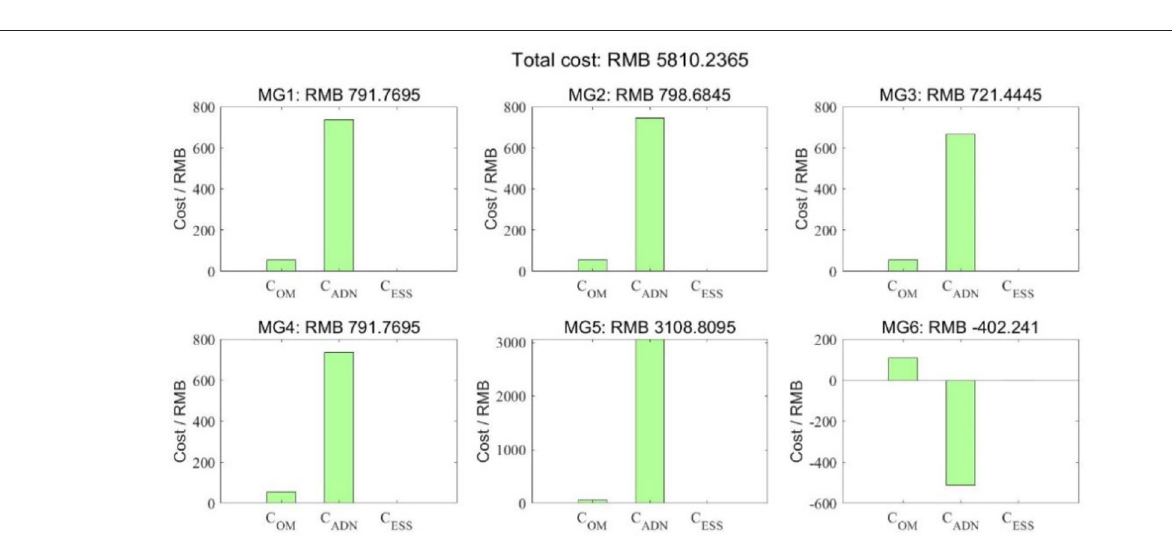
FIGURE 11 | The energy bills of each microgrid within the cluster in scenario